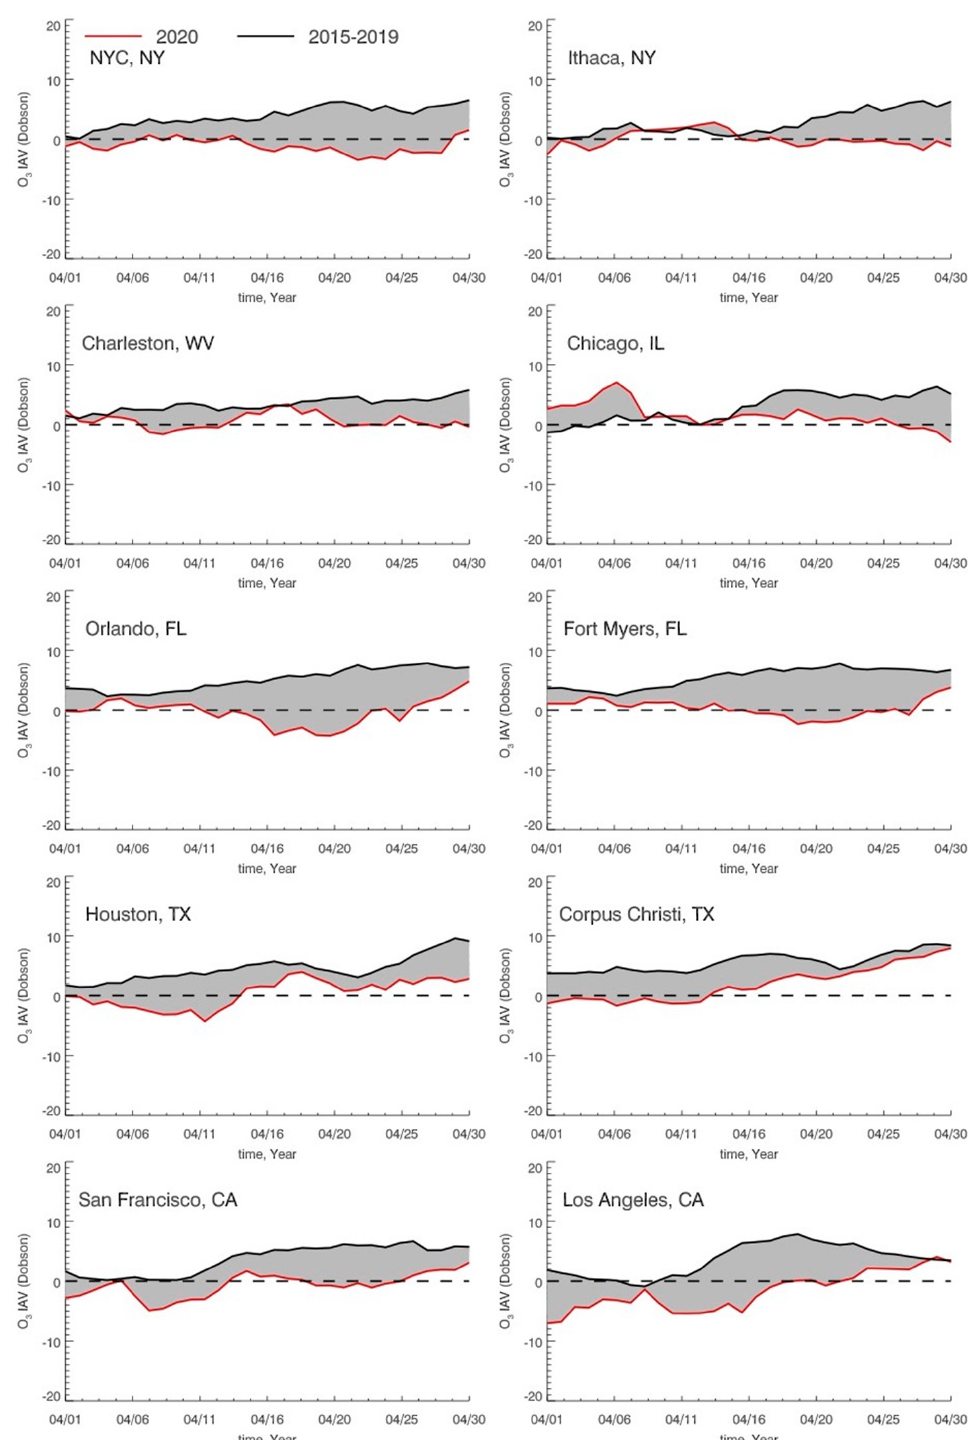
Figure 6. Same as Figure 5, but for O 3 tropospheric column. The relative IAV of AOD over NYC, NJ, DE, and WV was about 40%, 25%, 20%, and 20%, respectively. AOD levels were not significantly changed over these states (considering the IAV and the negative bias of the MODIS DB product, see Section 3.2). However, AOD levels were significantly increased by up to 80% in WV and downwind of NYC, covering large parts of Connecticut and Pennsylvania. The decrease in CO levels but increased AOD in these regions indicate that these AOD increases were related to aged air